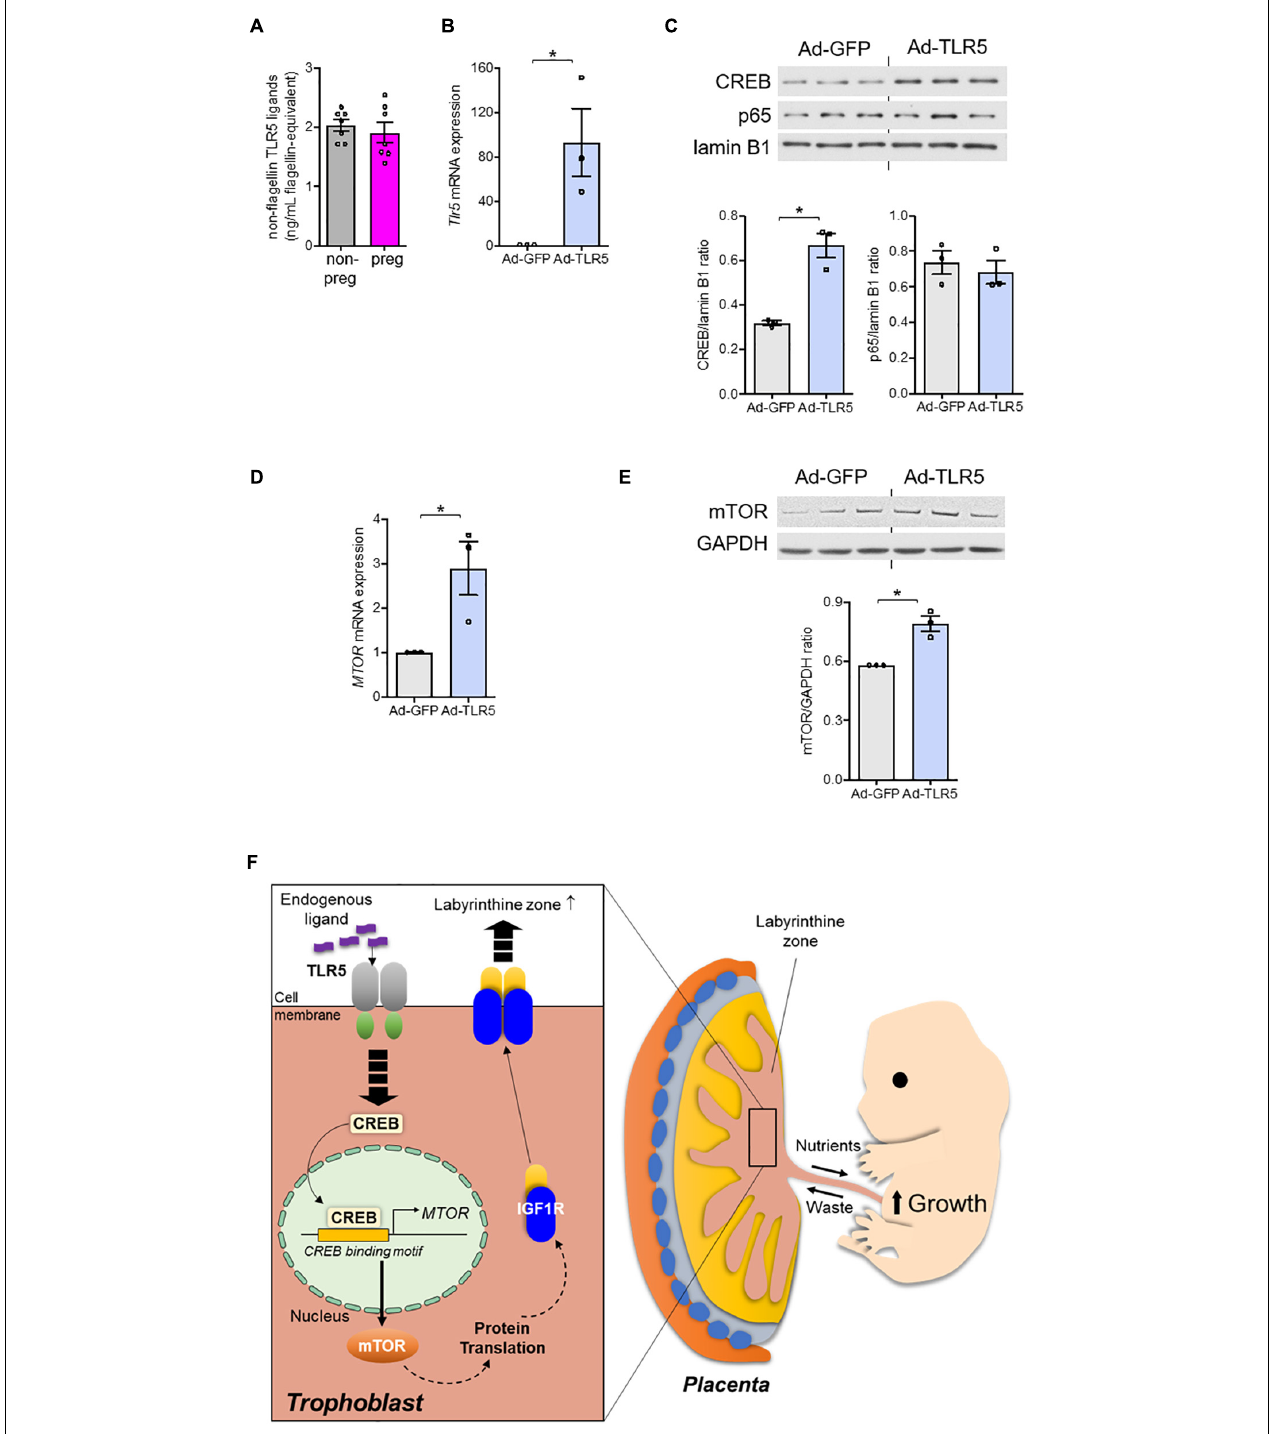
FIGURE 5 | Overexpression of TLR5 alone was sufficient to upregulate mTOR expression in trophoblasts. (A) Serum level of non-flagellin-based TLR5 ligands in wild type non-pregnant (non-preg) and pregnant (preg) mice at day 9.5 of gestation was measured ( n = 7 mice). (B–E) BeWo trophoblasts were infected with adenovirus (5 × 10 8 viral particle/mL) encoding GFP (Ad-GFP) or TLR5 (Ad-TLR5) overnight followed by determination of (B) Tlr5 mRNA expression, (C) nuclear CREB and p65 abundances, and mTOR (D) mRNA and (E) protein abundances ( n = 3 independent experiments). Lamin B1 was used as loading control for nuclear protein determination and GAPDH was used for the remaining experiments. (F) The findings of this study are depicted. Representative results and the densitometric analyses for immunoblotting are shown. Data are represented as mean ± SEM. The differences between treatments were determined by two-tailed Student’s t- test. * P <